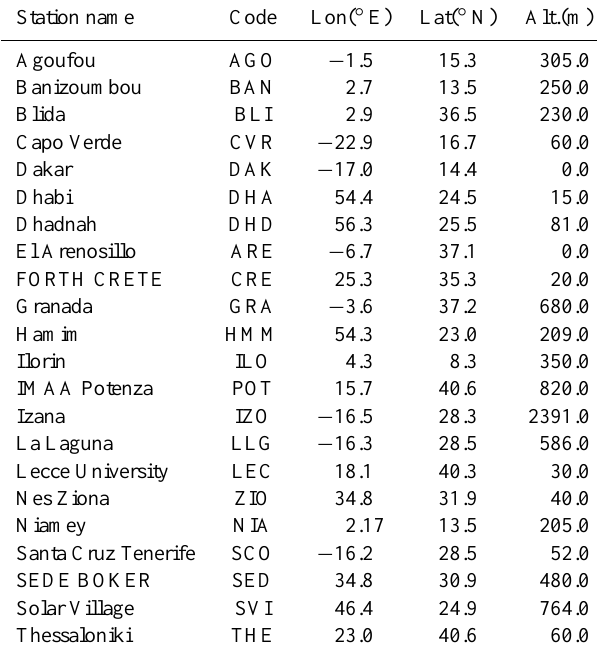
Table 3. Names, acronyms and coordinates of the AERONET sta- tions used in the regional